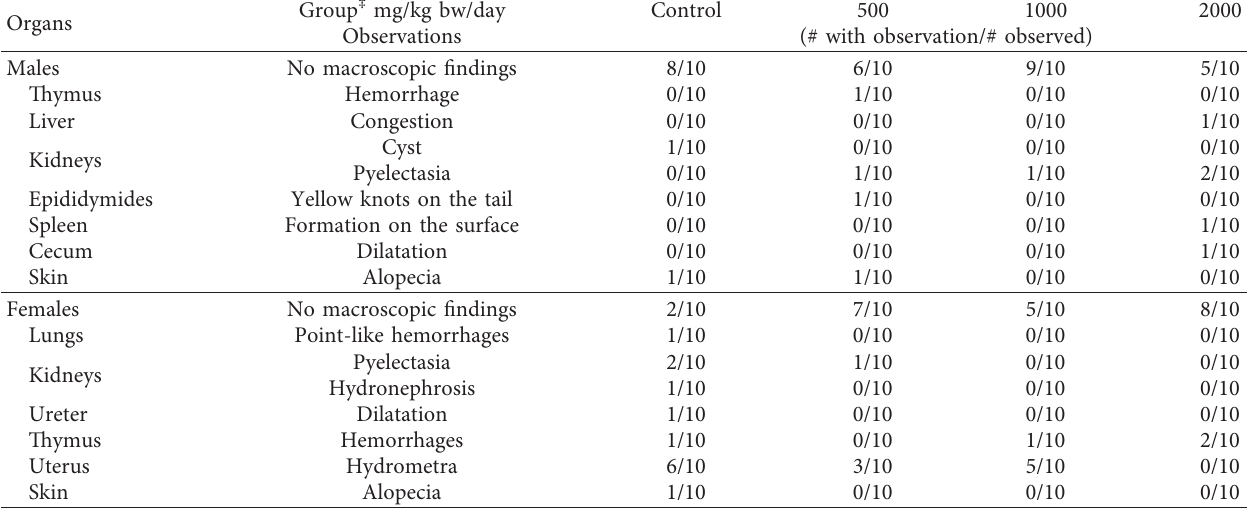
Table 10: Summary of macroscopic results, 90-day